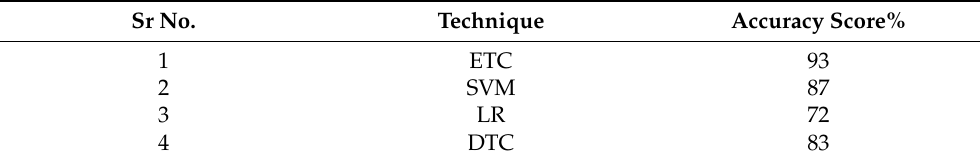
Table 3. The accuracy performance metric comparative analysis among the employed approaches. Sr